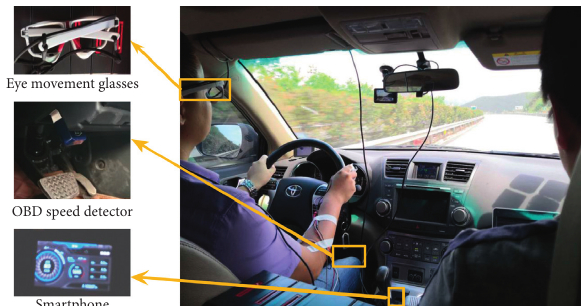
Figure 2: Vehicle and apparatus used in naturalistic driving